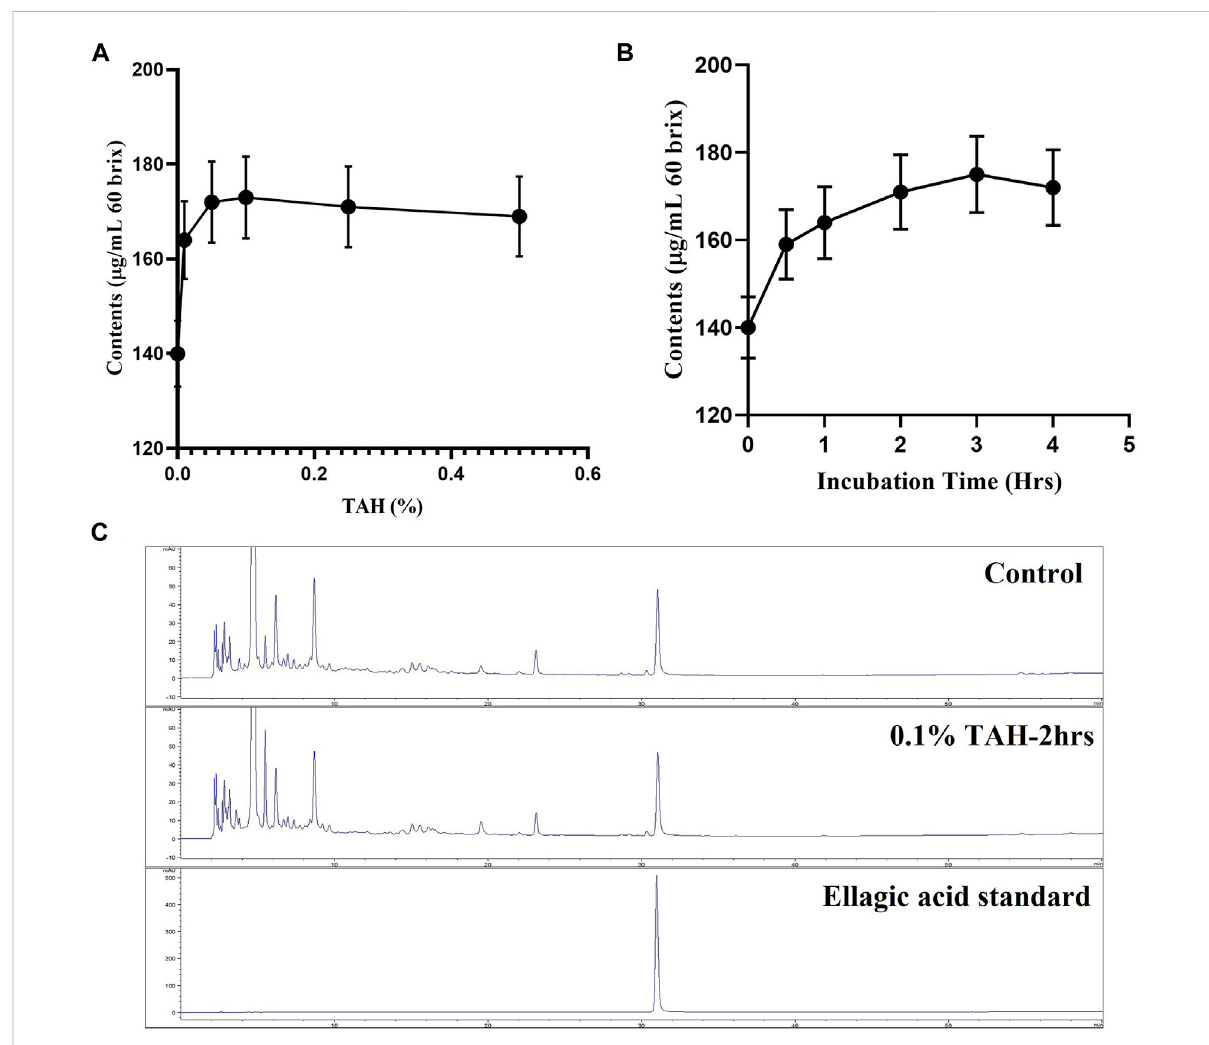
FIGURE 1 Optimization of Tannase treatment. (A) Condition of enzyme percentage (B) incubation time (C) HPLC analysis for Tannase treatment.